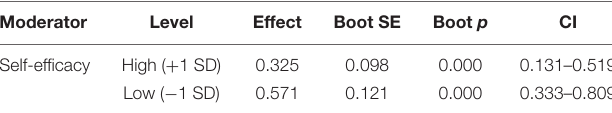
TABLE 6 | The test of moderated mediating effect (hindrance